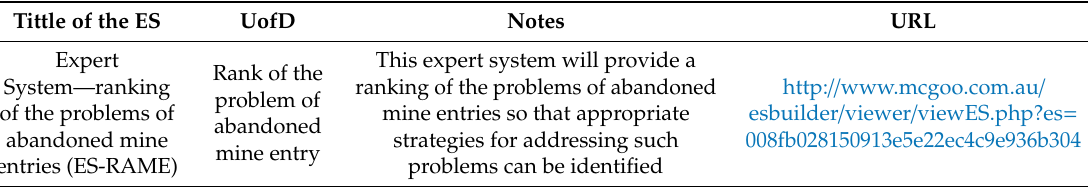
Table 6. The description of the developed expert